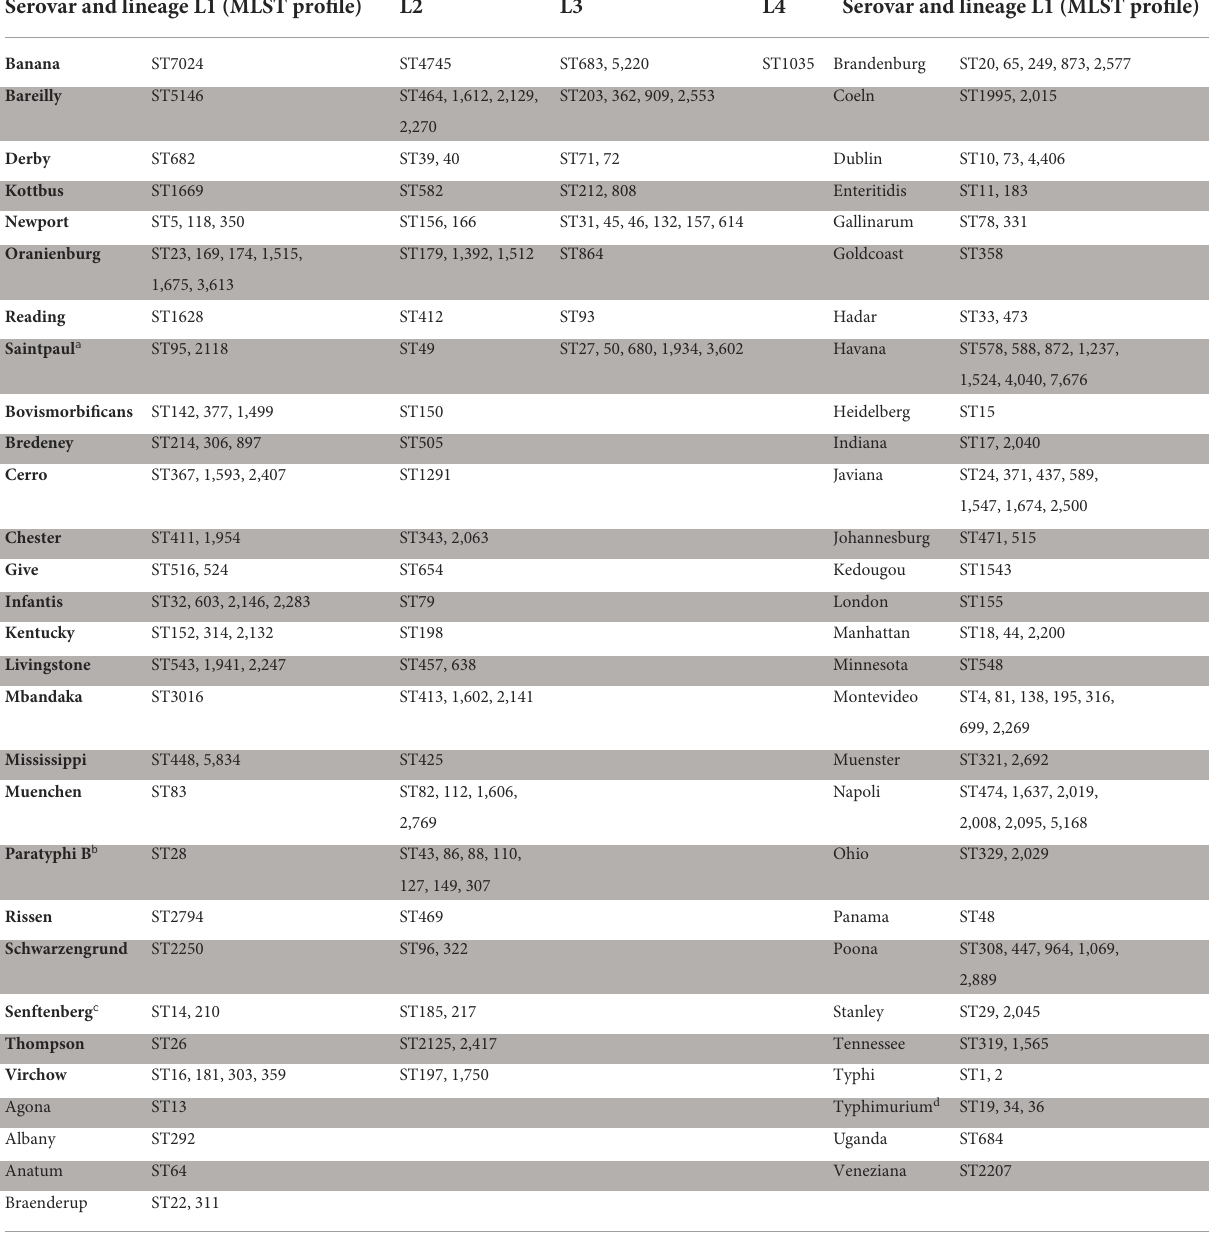
TABLE 2 Polyphyletic and monophyletic serovars studied. Serovar and lineage L1 (MLST profile) L4 Serovar and lineage L1 (MLST